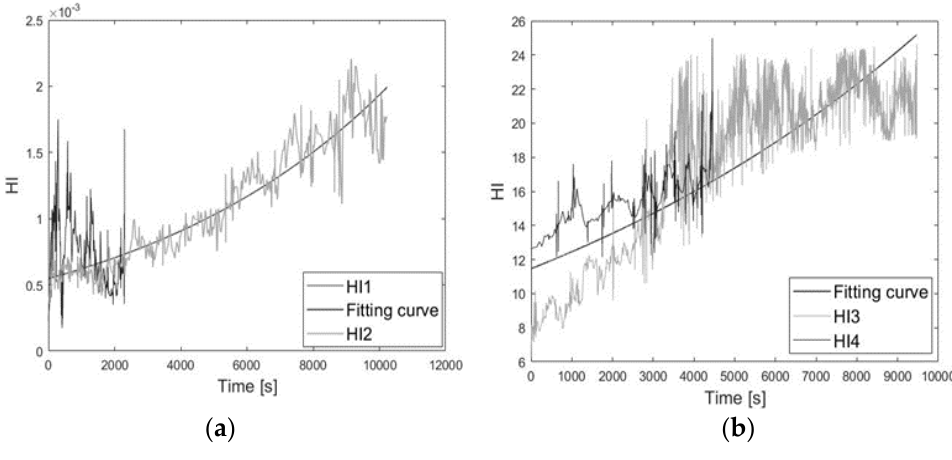
Figure 7. Constructed HIs for ( a ) setting 1 and ( b ) setting 2. Table 11. Monotonicity, trendability, and prognosability values of His constructed through GO for the two machinery settings.